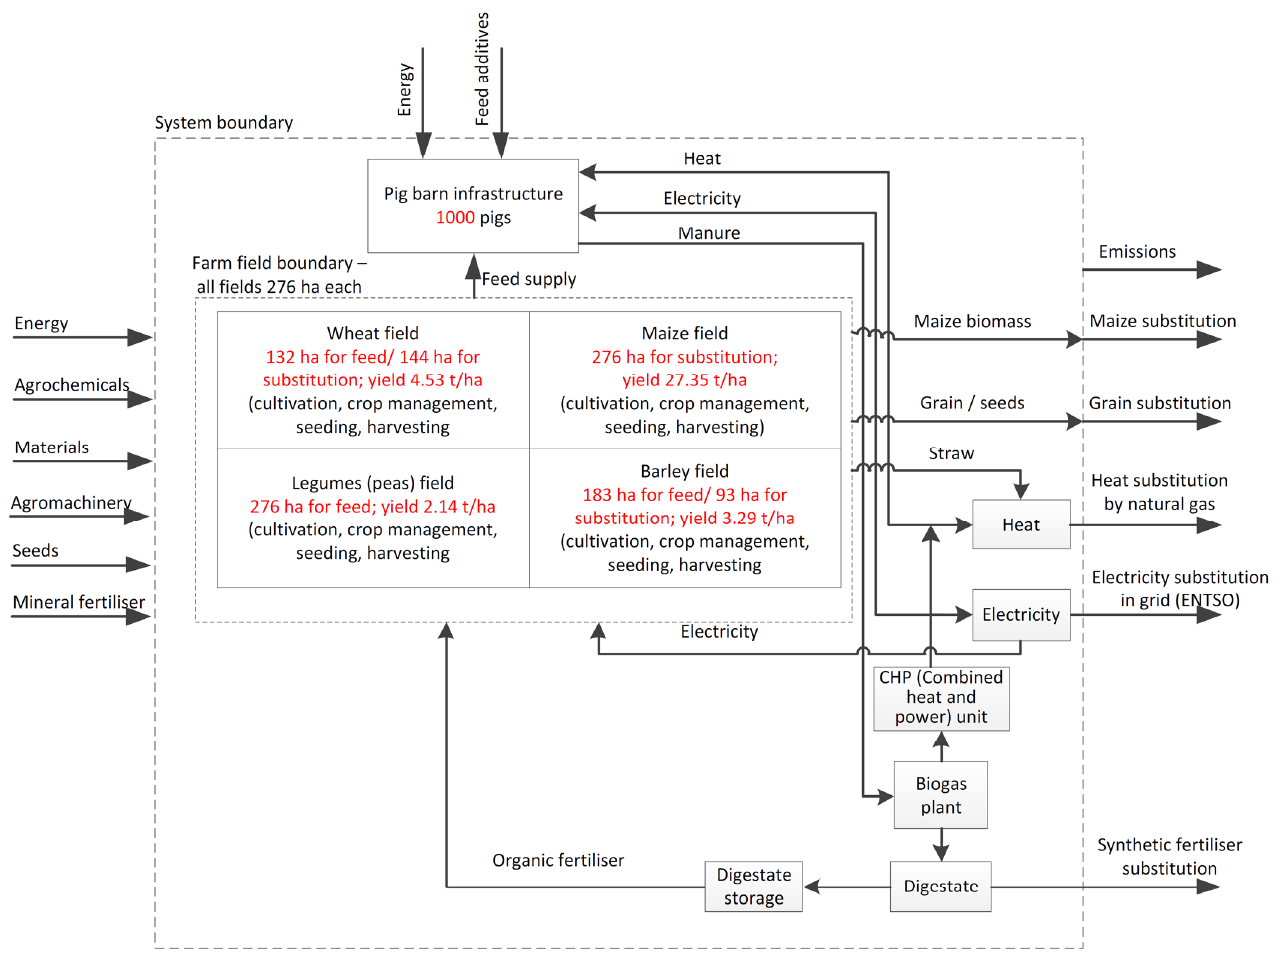
Figure 3. Schematic representation of the main processes and pathways considered for the pig farm in CS2.